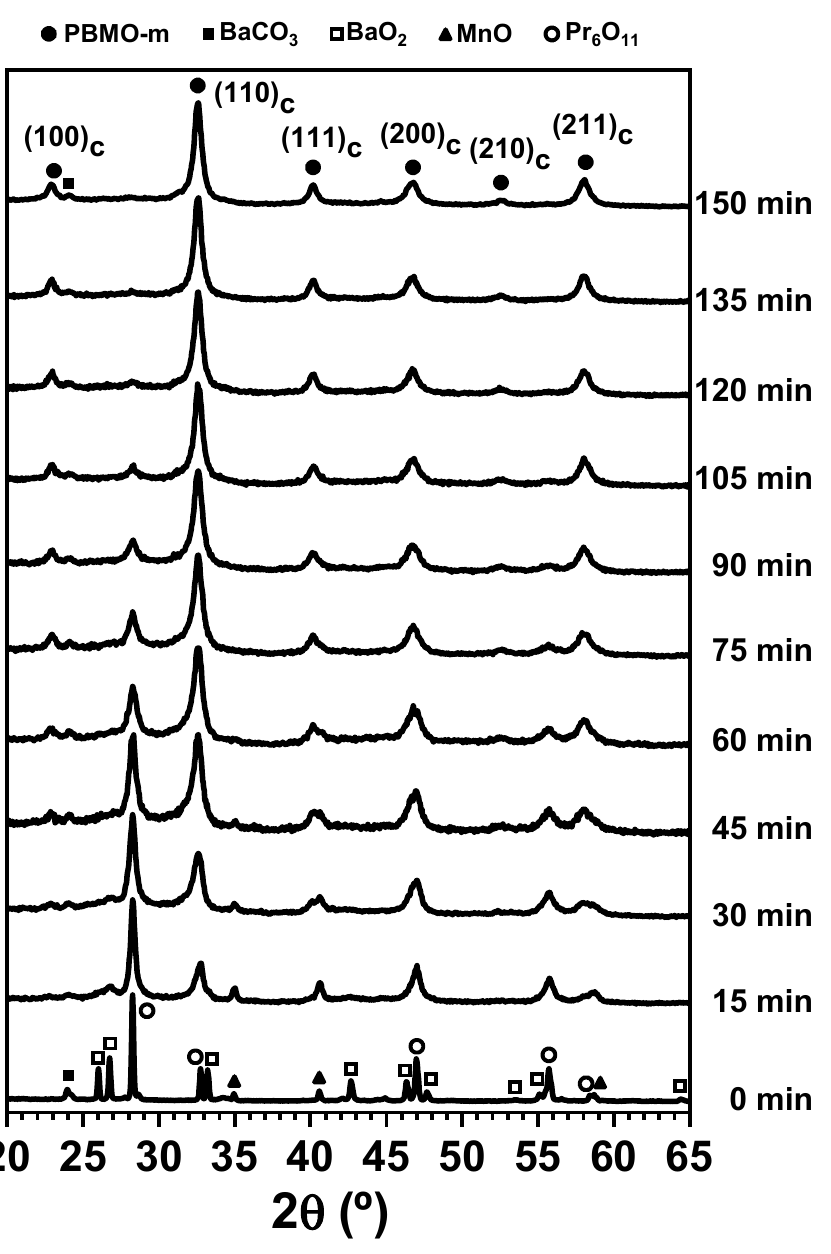
Figure 1. XRD patterns of the Pr 6 O 11 /BaO 2 /MnO powder mixture subjected at increasing milling time.